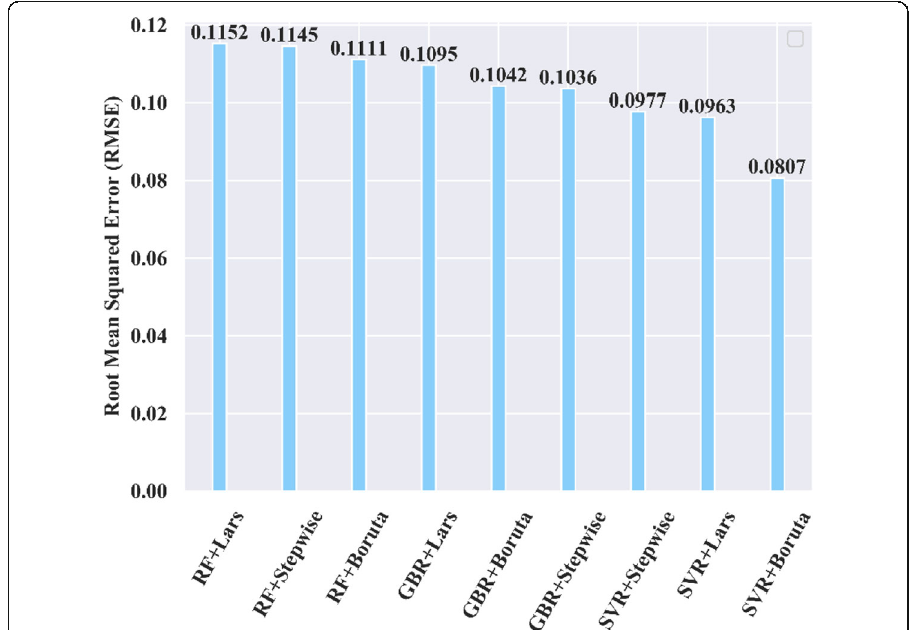
Fig. 7 The RMSE comparison of nine hybrid